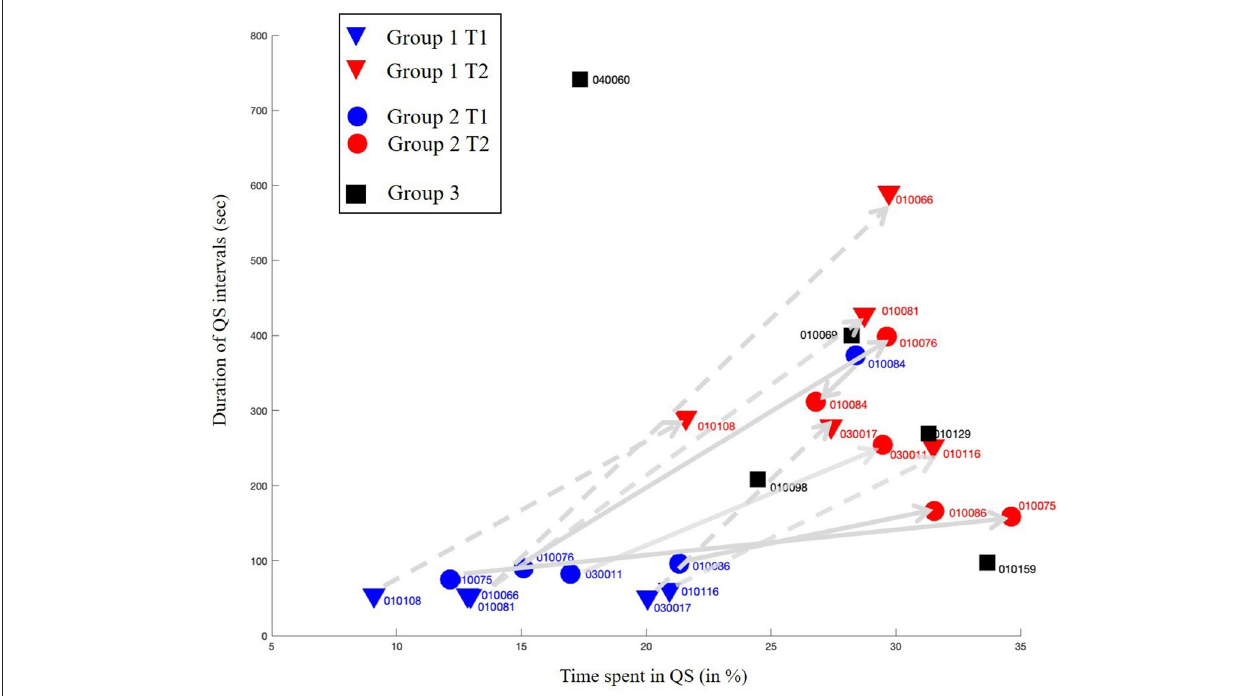
FIGURE 4 | ADI of quiet sleep intervals according to the percentage of time spent in quiet sleep (QS). Arrows show the evolution of the values between T1 and T2 for each newborn of group 1 (dashed line) and group 2 (solid line). There is no increase in QS percentage for the preterm infant N ◦ 010084, this could be explained by a short period between the two recordings on his gestational age which represents a late preterm of group 2.